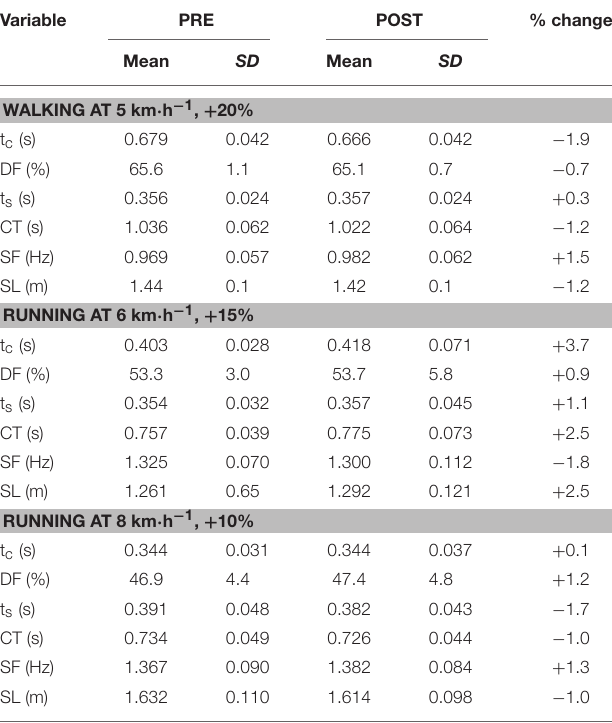
TABLE 2 | Changes in the kinematics data measured before (PRE) and after (POST) the MUM ( n = 19).